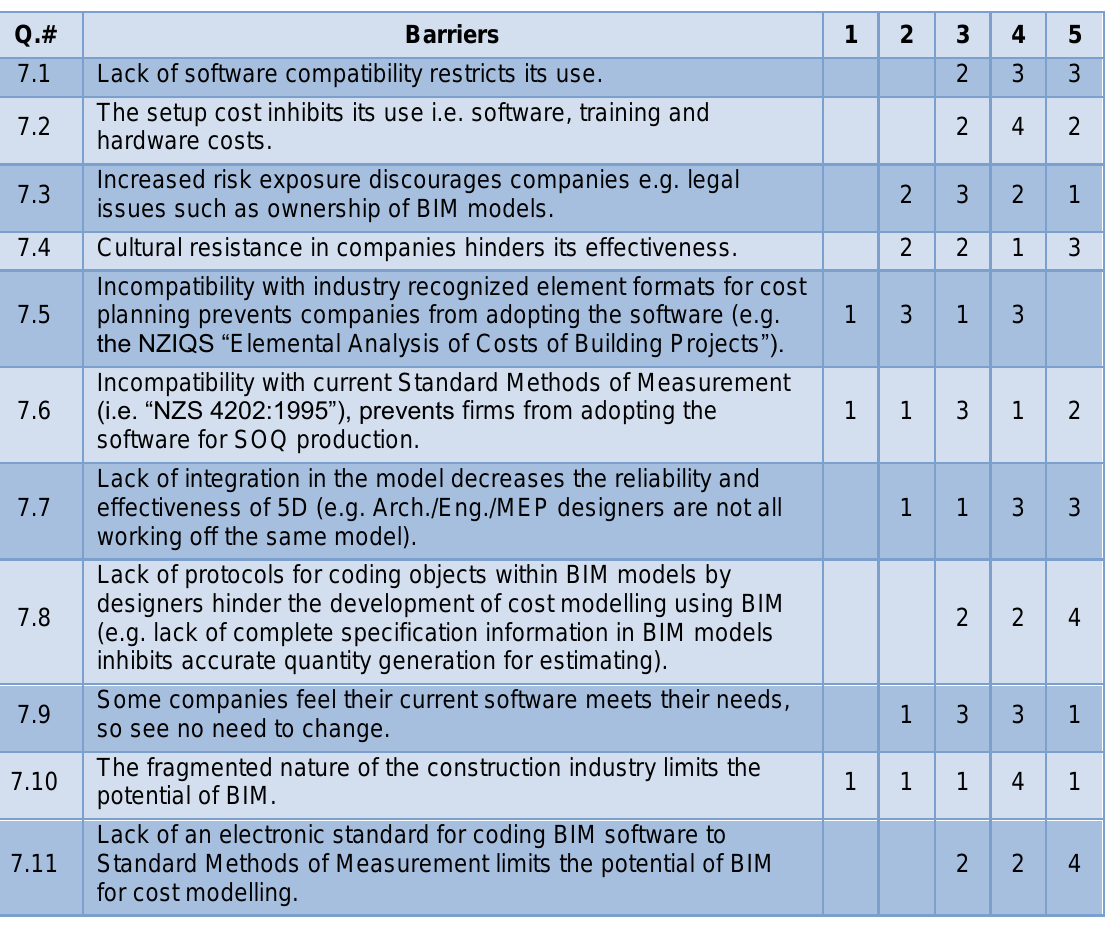
Table 3 Statements Relating to Potential Barriers to 5D Implementation